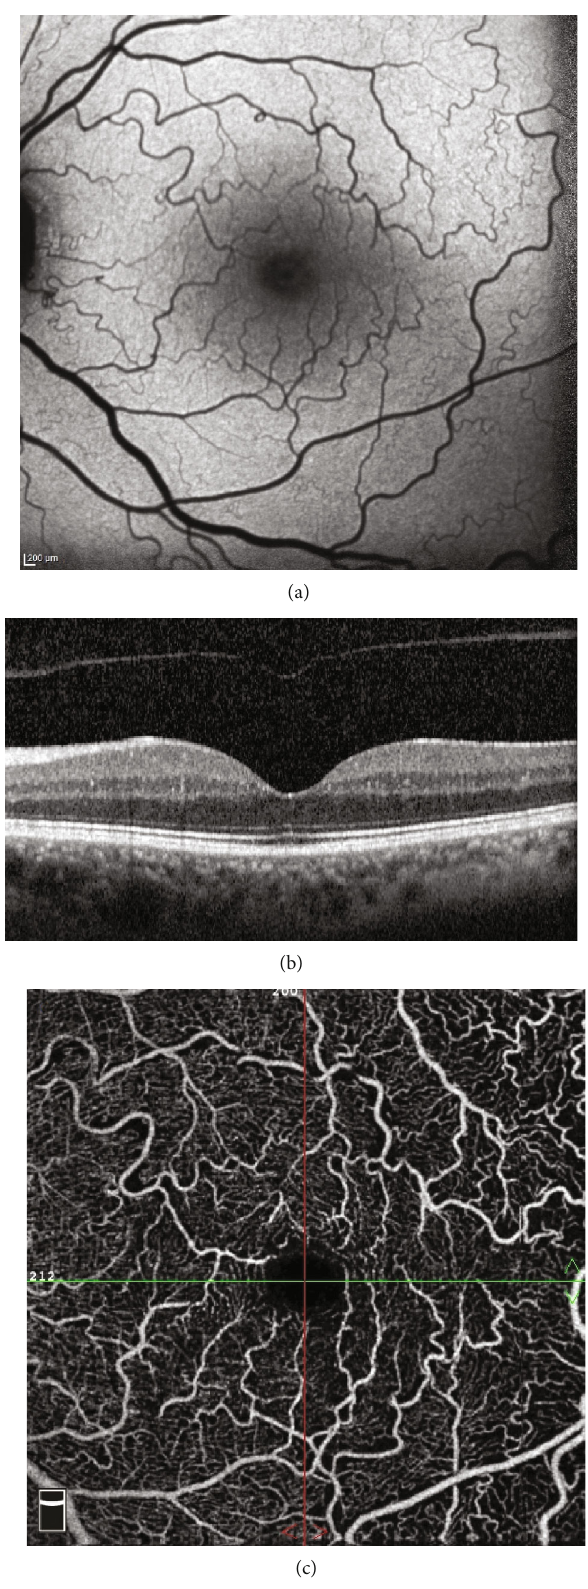
Figure 3: Fundus auto fl uorescence (a), optical coherence tomography (b), and optical coherence tomography angiography (c) imaging of the left